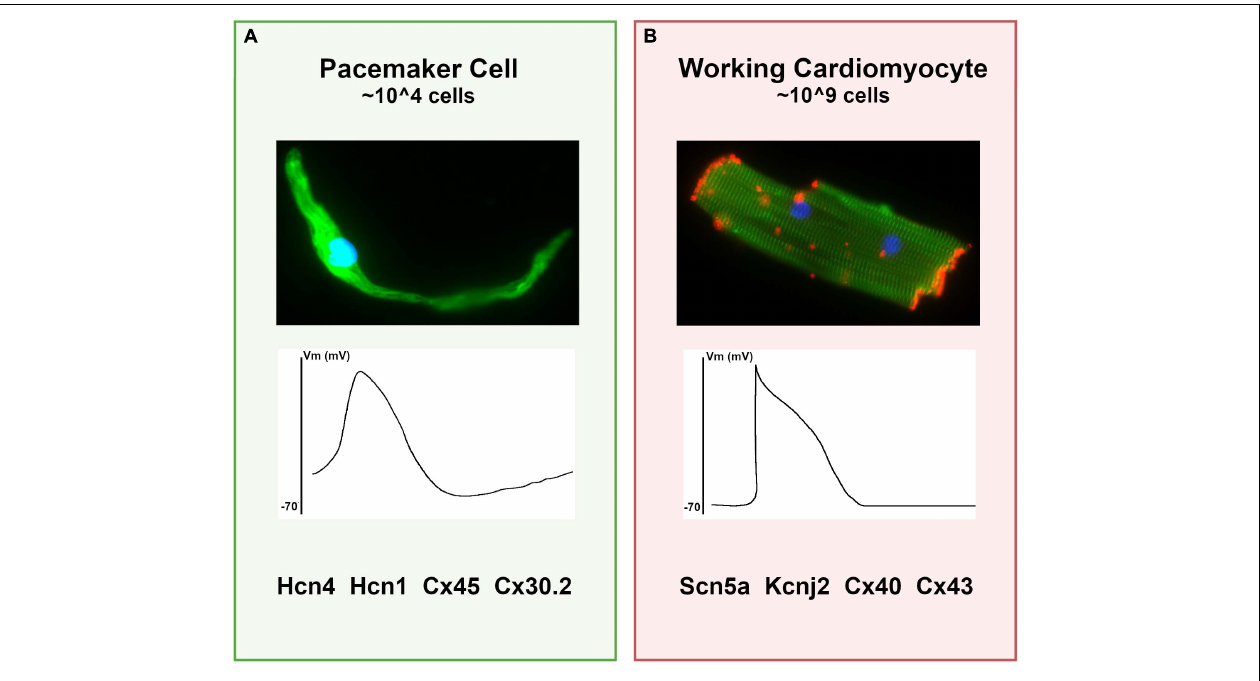
FIGURE 1 | Differences between pacemaker cells and working cardiomyocytes. (A) Characteristics of typical pacemaker cells: (top panel) micrograph of an isolated pacemaker cell taken from an adult Hcn4-GFP mouse demonstrates an elongated spindle-like morphology; (middle panel) a typical pacemaker cell action potential with elevated resting membrane potential and diastolic depolarization; (bottom panel), a list of key functional proteins enriched in pacemaker cells. (B) For comparison, typical ventricular cardiomyocyte characteristics are shown, including (top panel) a micrograph of an adult mouse ventricular cardiomyocyte stained for alpha-actinin (green) to demonstrate sarcomeres and connexin-43 (red) to demonstrate gap junctions; (middle panel) a typical working cardiomyocyte is quiescent with a negative resting potential, rapid upstroke, and plateau phase; (bottom panel) key functional genes expressed in working cardiomyocytes that are reduced in pacemaker